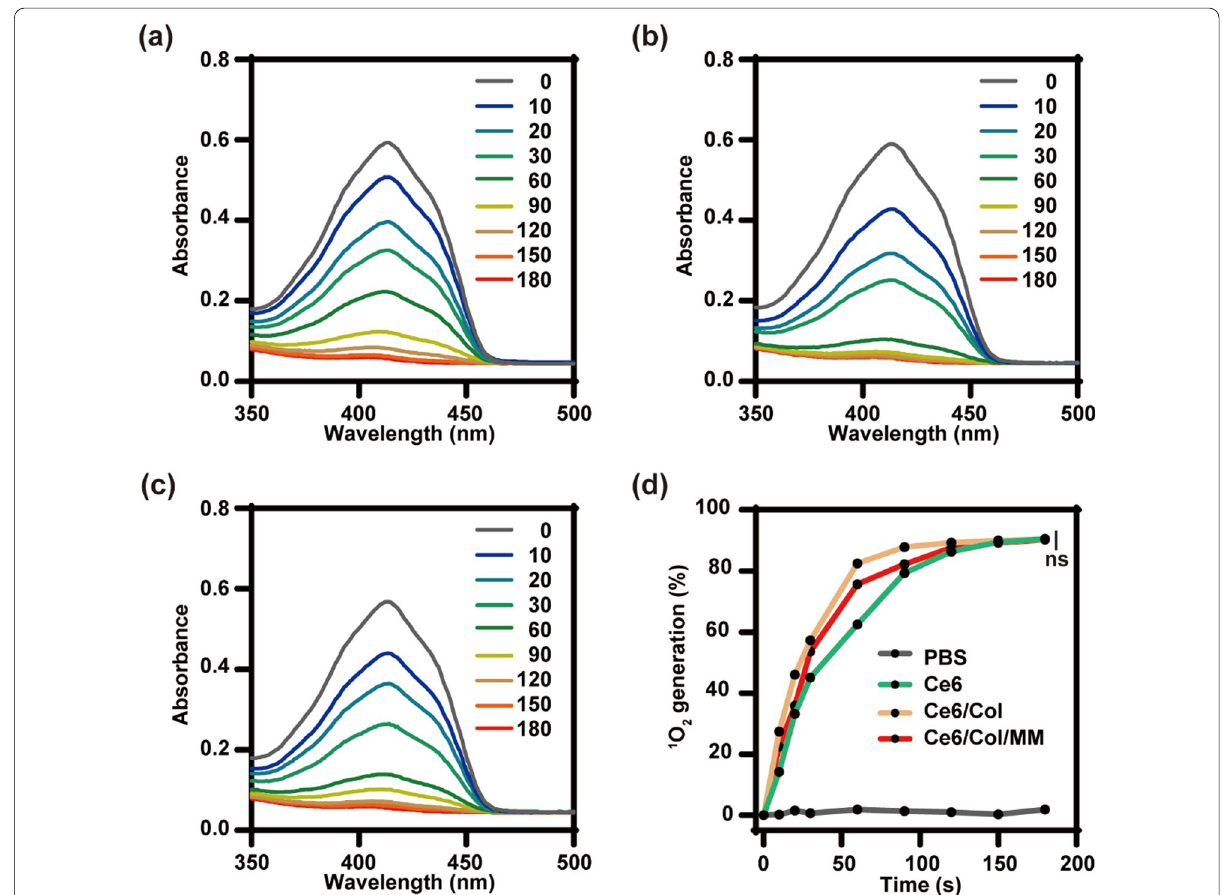
Fig. 2 Photodynamic activity of Ce6/Col/MM. a Ce6, b Ce6/Col or c Ce6/Col/MM containing DPBF, 1 O 2 trapping agent, was irradiated with 660 nm and the absorbance reduction of DPBF at 410 nm indicates the generation of singlet oxygen. d Singlet oxygen generation percentages of Ce6, Ce6/ Col and Ce6/Col/MM at predetermined time points based on ( a )–( c ). ns: no significant difference compared to free Ce6 and